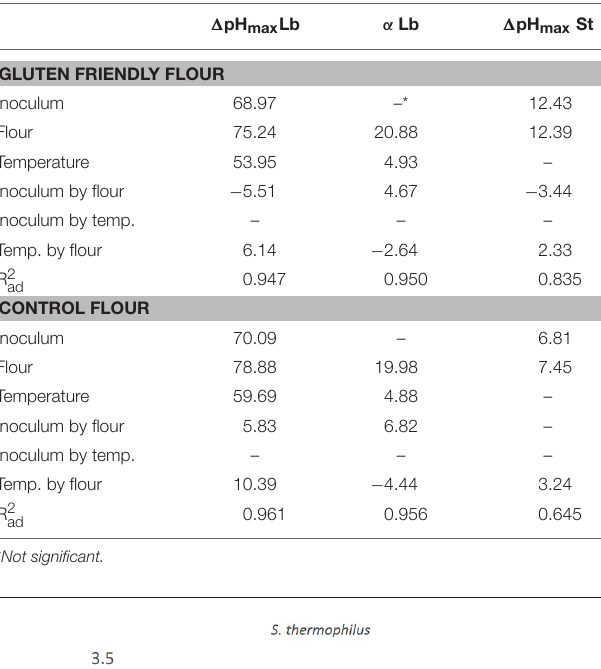
TABLE 2 | Standardized effects of inoculum, flour and temperature on acidification ( 1 pH max ) of L. delbrueckii subsp. bulgaricus (Lb) and S. thermophilus (St) and on the time before the beginning of acidification ( α ) of L. bulgaricus . R 2 ad , adjusted regression coefficient.